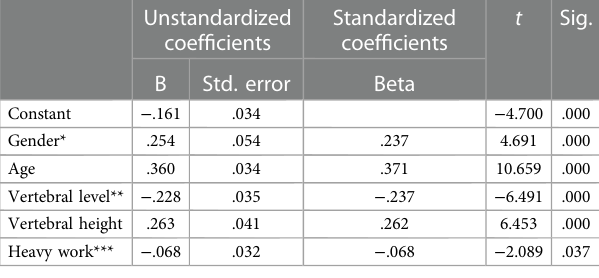
TABLE 1 List of signi fi cant predictors. Unstandardized coef fi